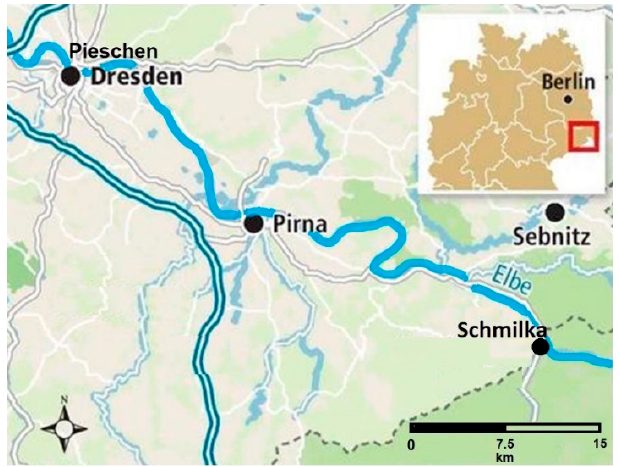
Figure 1. The investigated 60 km reach of the River Elbe between Schmilka and Pieschen (District of the City of Dresden).